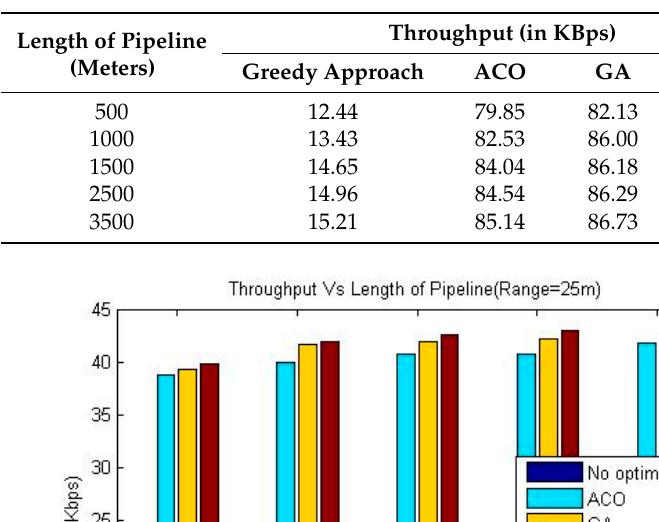
Table 7. Comparison of Throughput (Range 100 m).